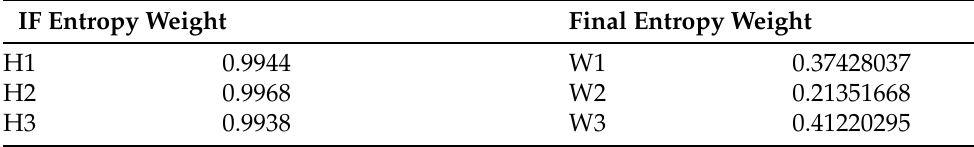
Table A9. IF entropy weights and final entropy weight for intra-organizational sub-barriers.